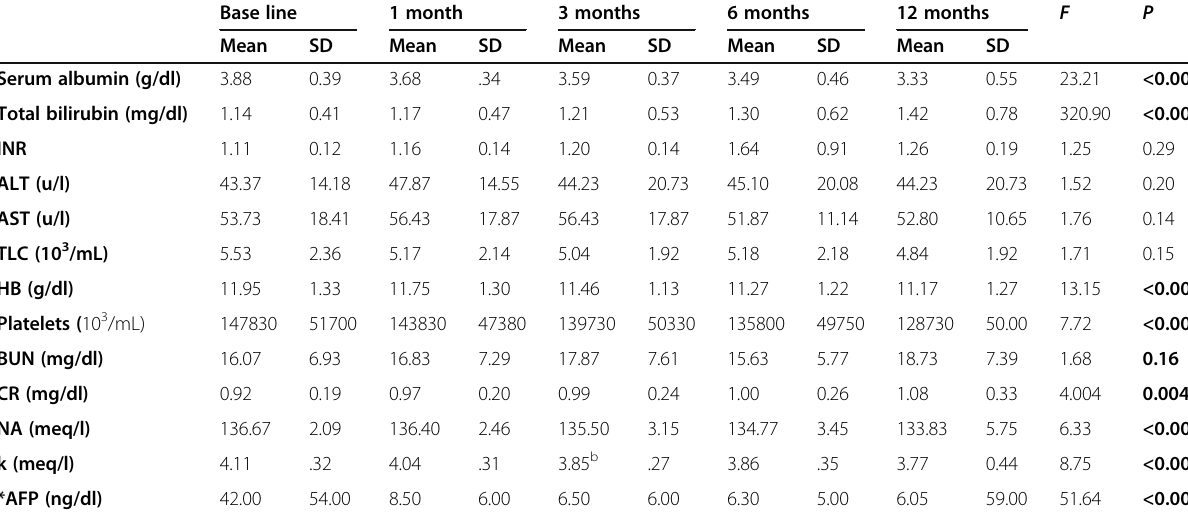
Table 2 Laboratory investigations during 12 months of follow-up Base line